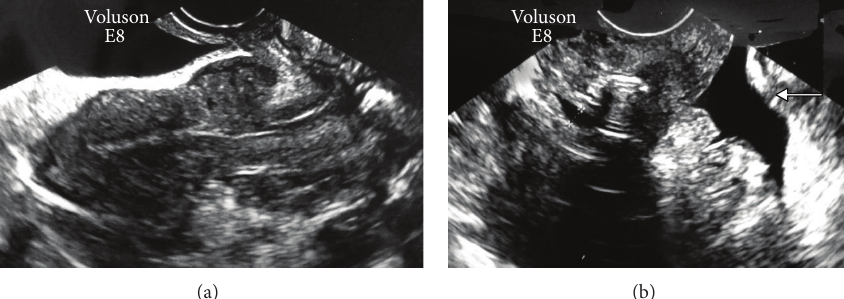
Figure 1: Ten months after the cesarean section. (a) Transvaginal ultrasonography shows a normal-sized uterus, but a clot-like mass with a low-to-iso-echoic inhomogeneous content, measuring 20 × 15 mm, is shown at a location corresponding to the site of a uterine incision in the vesicouterine pouch. (b) Saline infusion sonohysterography was performed using a physiological saline solution. During the saline infusion the uterine lumen did not expand and a fistula, measuring 4mm in diameter, was observed (+---+). The images show that the physiological saline solution flowed out and spread from the uterine cavity into the peritoneal cavity through the vesicouterine pouch. In addition, the findings show that when the infusion continued, the saline solution accumulated in the Pouch of Douglas (arrow).